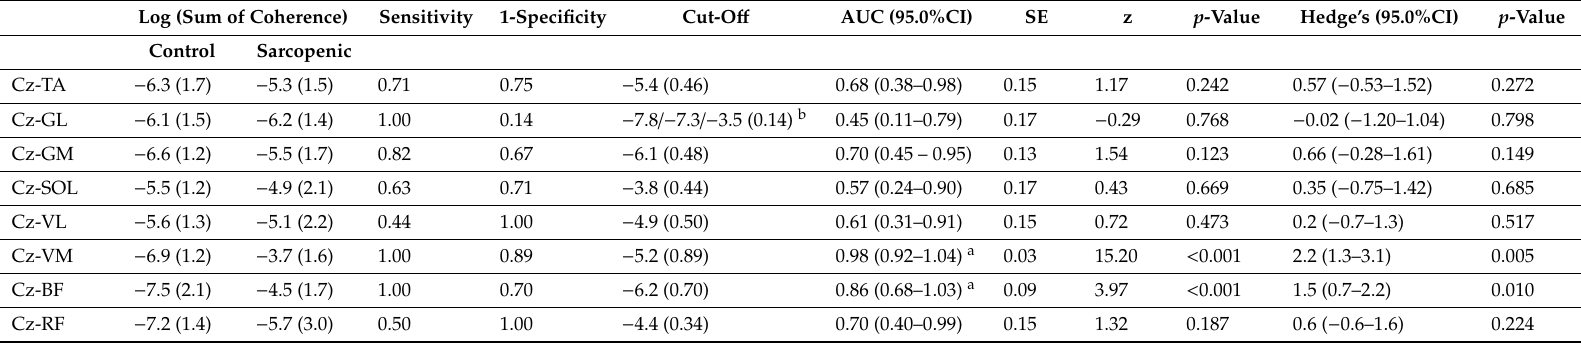
Table 4. Descriptive Statistics of the logarithmically transformed sum of coherence above significant confidence limits reported as mean (standard deviation) and results of the Receiver Operating Characteristic (ROC) curve analysis as well as DABEST comparisons with respective e ff ect